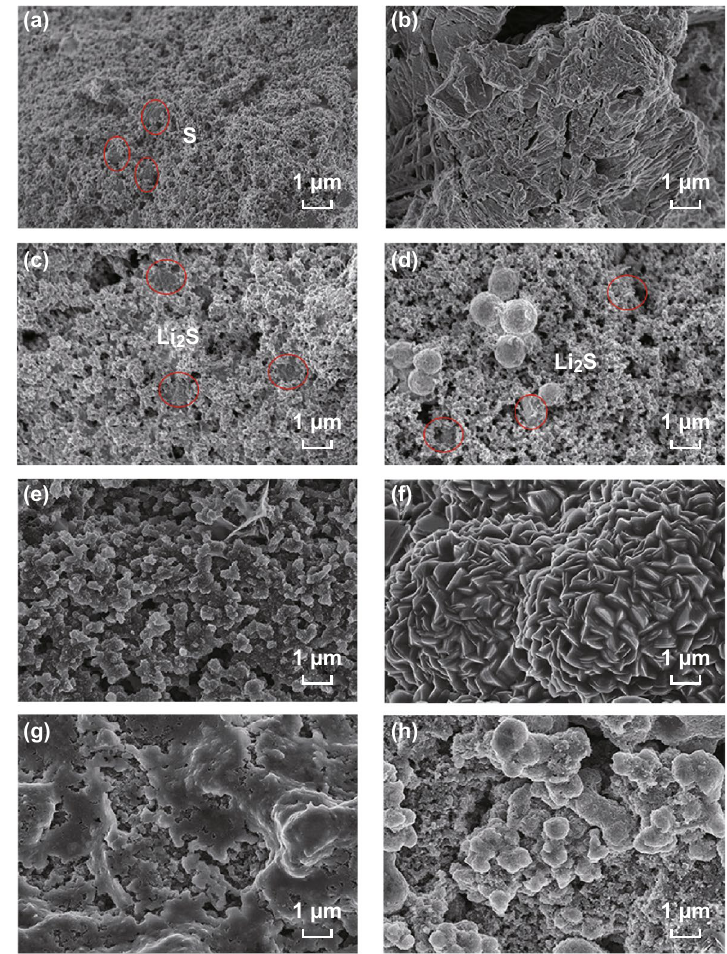
Fig. 5 SEM images of Li 2 S and S deposition in the redox reactions of the Li–S cells. a SEM images of the pristine CNT/S‑1.7 cathode. b SEM images of Li 2 S deposited on the CNT/S‑1.7 cathode in the PP coin cell after the first 100% discharge at 0.05 C. SEM images of Li 2 S deposition on the CNT/S‑1.7 cathode c and the separator d in the CN@PP coin cell after the first 100% discharge at 0.05 C. SEM images of Li 2 S deposition onto the CNT/S‑1.7 cathode e and the separator f in the Edg‑MoS 2 /C@PP coin cell after the first 100% discharge at 0.05 C. SEM images of the CNT/S‑1.7 cathode g and the separator h in the Edg‑MoS 2 /C@PP coin cell after the first 100% charge at 0.05